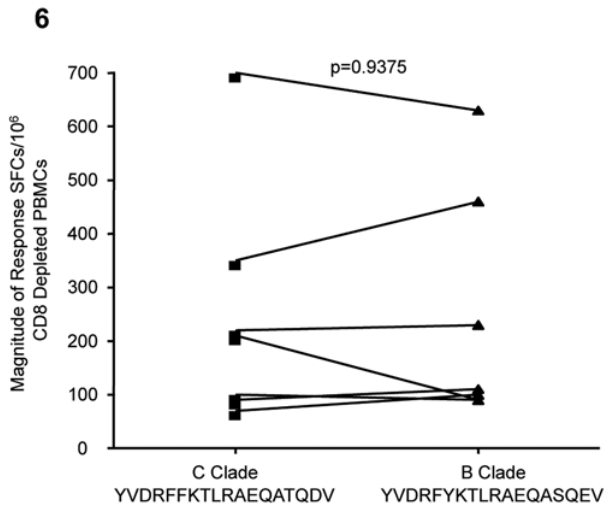
Figure 6. Cross clade recognition of the p24 Gag peptide YVDRFFKTLRAEQATQDV. In a subset of 28 subjects, we found that the C and B clade versions of peptide YVDRFFKTLRAEQATQDV induced the same magnitude of IFN- c response in 7 patients, as detected by the ELISPOT assay.